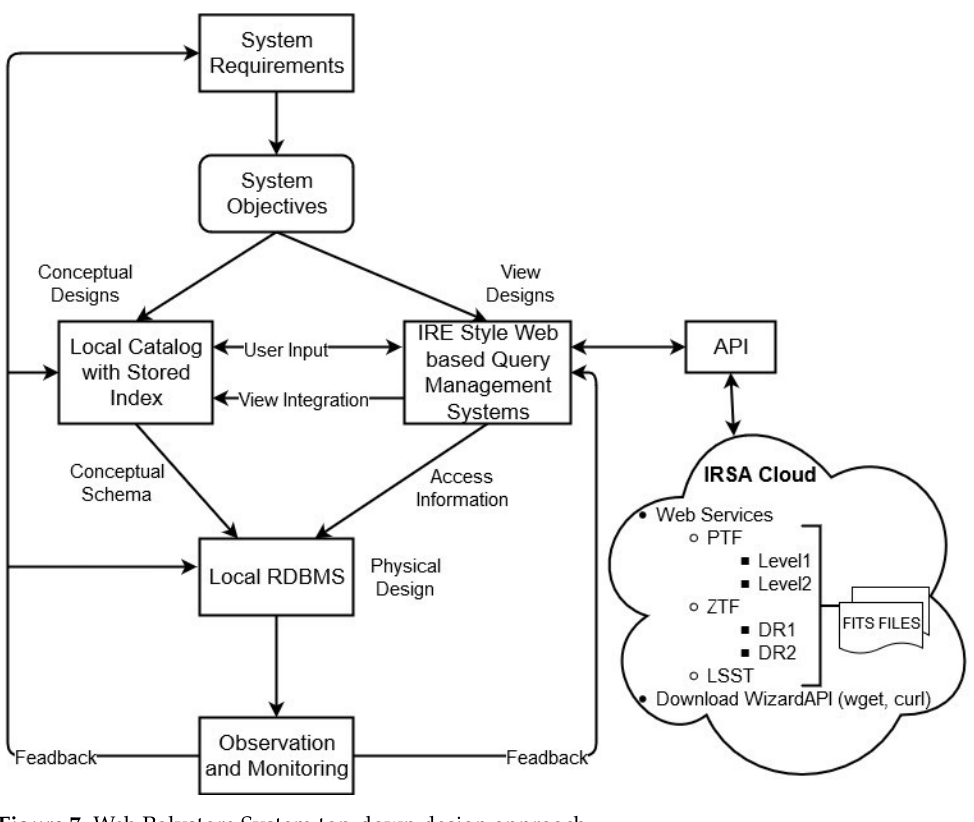
Figure 7. Web Polystore System top-down design approach.